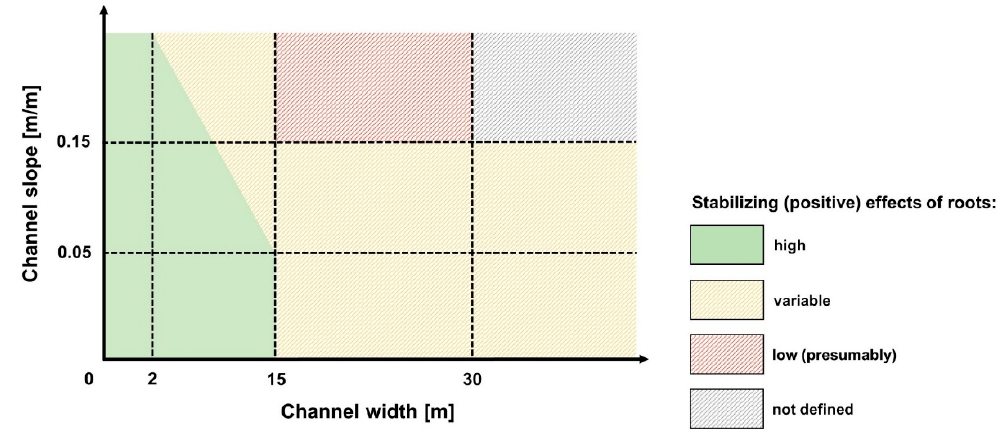
Figure 12. Susceptibility matrix to hydraulic bank erosion highlighting the stabilizing effects of